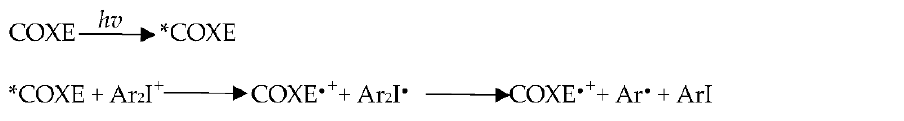
Scheme 4. Proposed photochemical mechanisms for the Iod-PF 6 /COXE